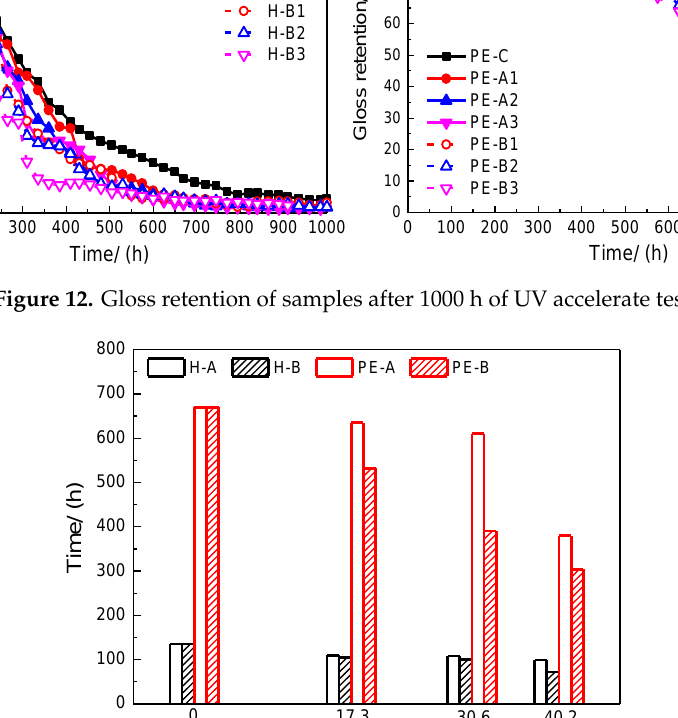
Figure 12. Gloss retention of samples after 1000 h of UV accelerate test.